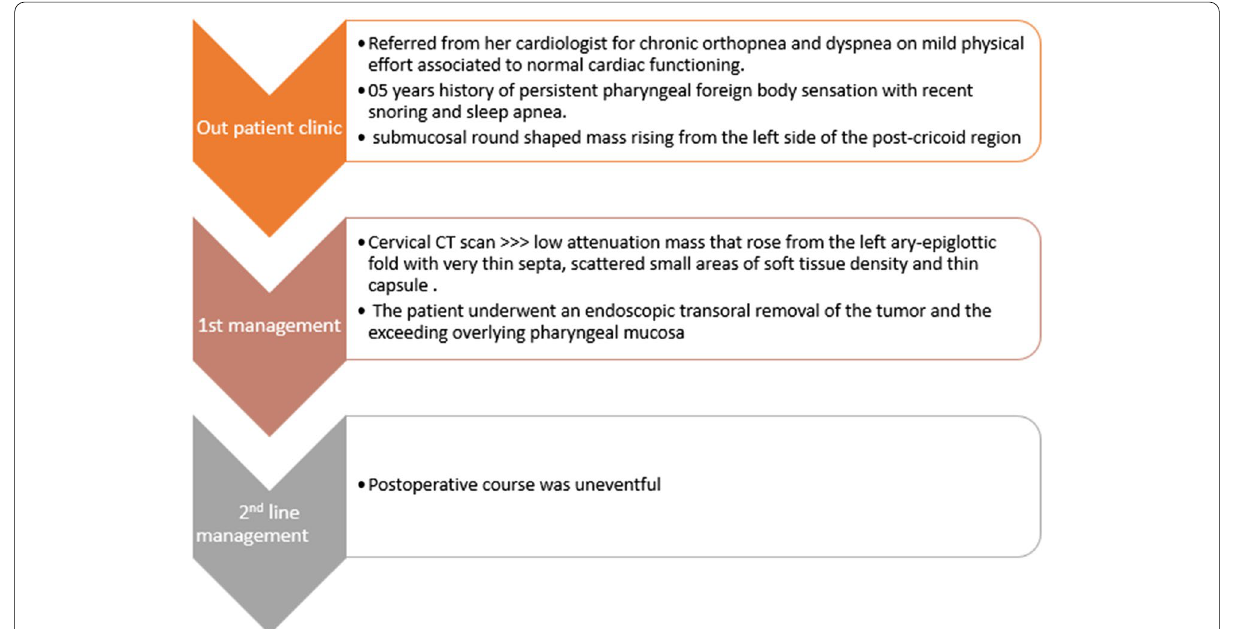
Fig. 5 Patient’s case management